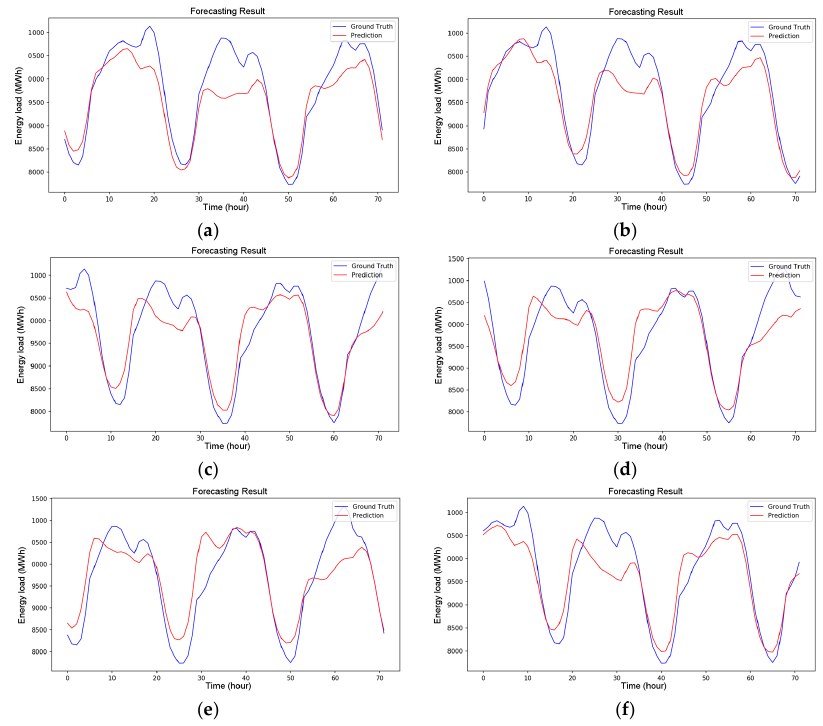
Figure 6. The forecasting results of support vector machine (SVM): ( a ) Partial results A; ( b ) Partial results B; ( c ) Partial results C; ( d ) Partial results D; ( e ) Partial results E; ( f ) Partial results F.